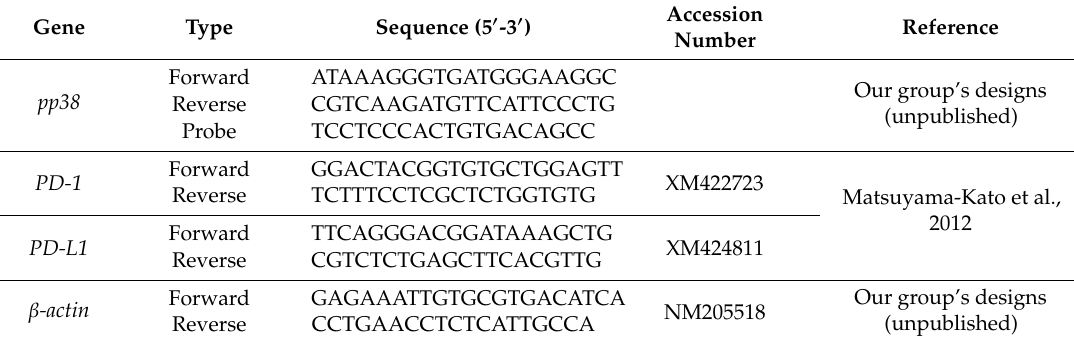
Table 2. Primers used for the real-time